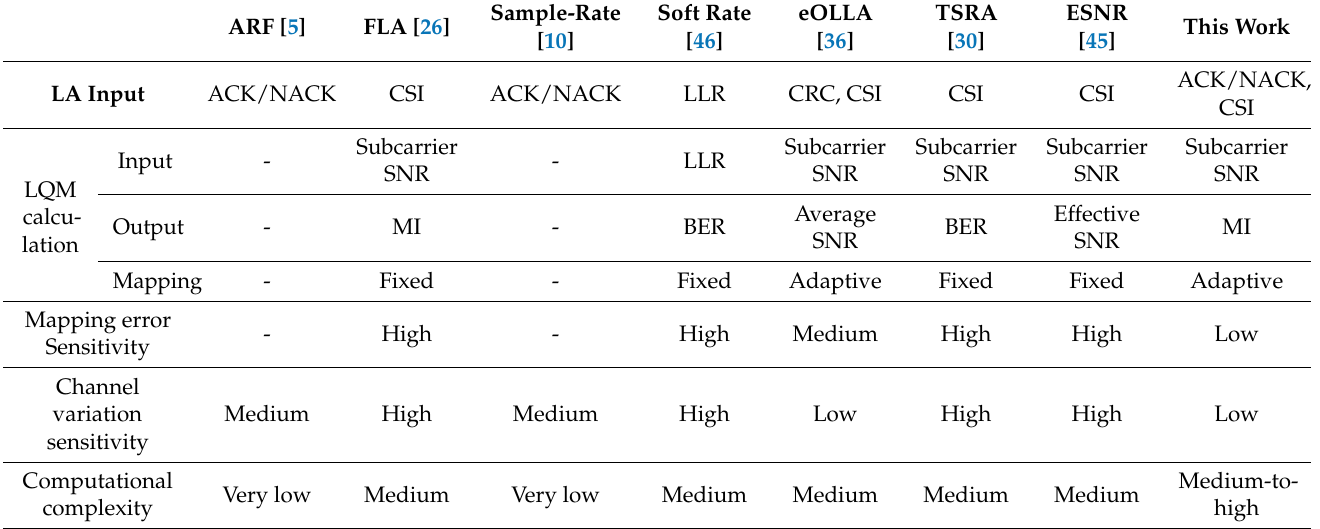
Table 3. Comparison of this work and selected other